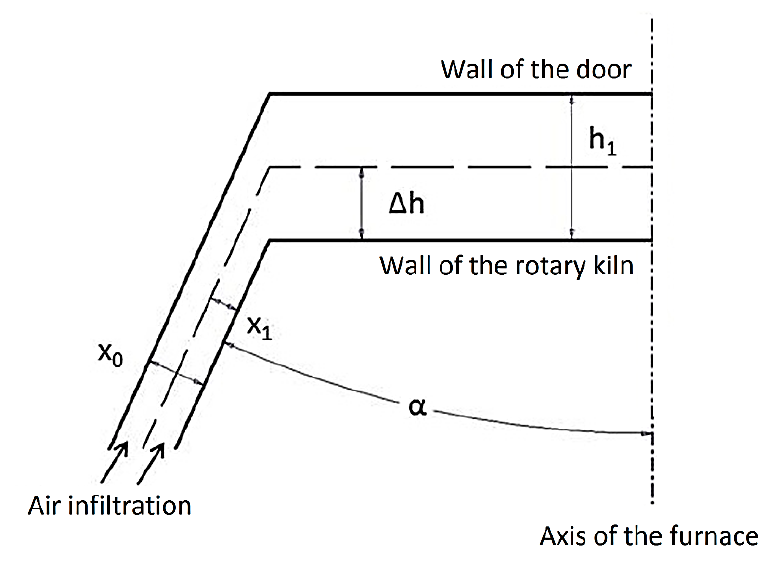
Figure 2. Visualization of gap width estimation.